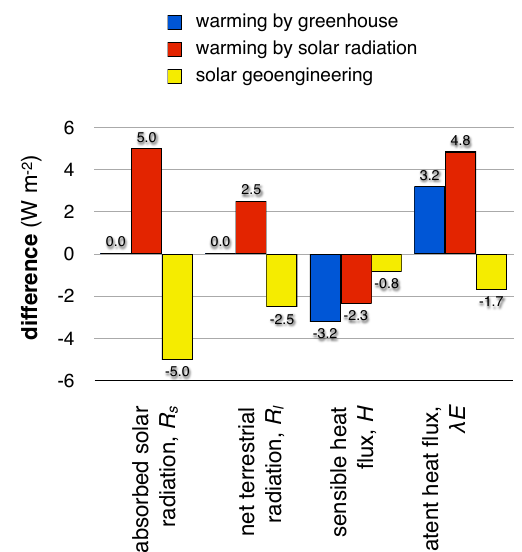
Fig. 3. Estimates of the changes in the surface energy balance components due to a warming of 1T s =2K caused by an in- crease in the atmospheric greenhouse effect (blue, “warming by greenhouse”), by an increase in absorbed solar radiation (red, “warming by solar absorption”), and when a greenhouse warm- ing of 2K is compensated for by a reduction of solar radiation by some geoengineering management (yellow, “solar geoengineer- ing”). The numbers are obtained using values of R s =240Wm − 2 and k r =3.64Wm − 2 K − 1 for the present-day climate, a reduction of k r to k r =3.44Wm − 2 K − 1 to get a surface warming of 2K by changes in the greenhouse effect, an increase of 1R s =5Wm − 2 to get a surface warming of 2K by changes in absorption of so- lar radiation, and a combined change of k r =3.44Wm − 2 K − 1 and 1R s = − 5Wm − 2 to implement the solar radiation management